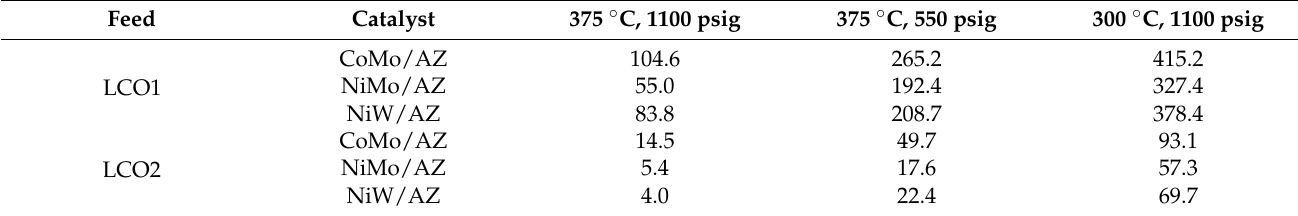
Table 6. Nitrogen (ppm) content in the final products with different LCO